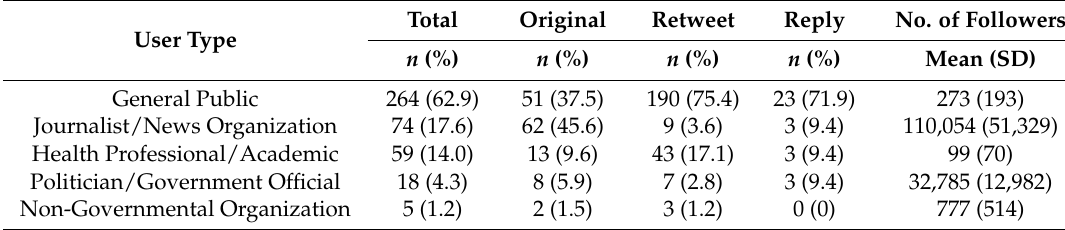
Table 1. Characteristics of tweets by users with publically available profiles.